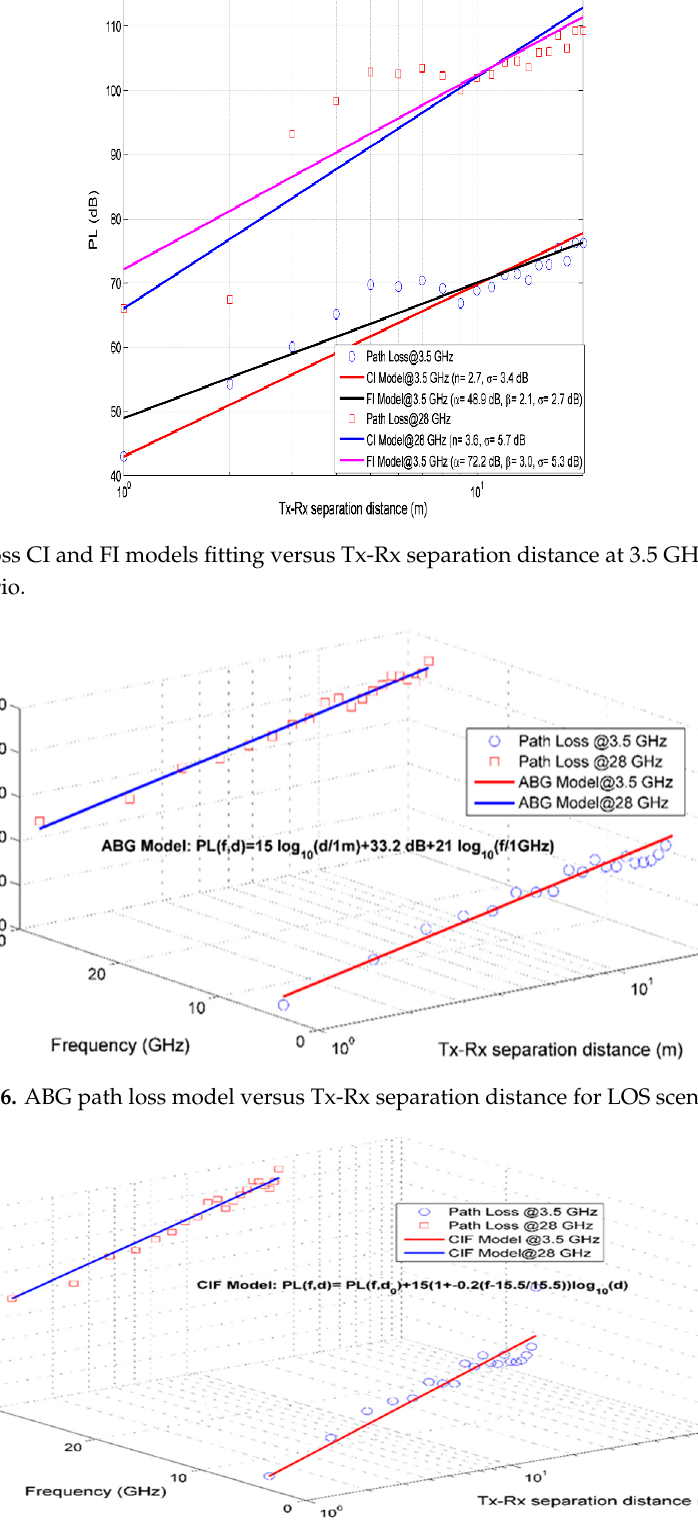
Figure 5 . Path loss CI and FI models fitting versus Tx-Rx separation distance at 3.5 GHz and 28 GHz for NLOS scenario.